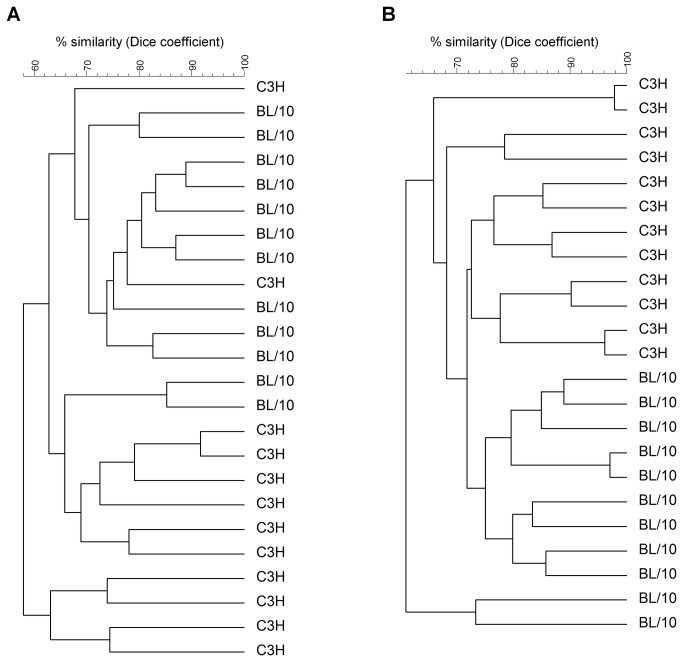
Cluster formation of C3H and C57BL/10 mice according to their luminal (A) and mucosa-associated (B) microbiota.Microbiota similarity in previously germ-free mice was calculated 13 weeks after association with the same bacterial inoculum using the Dice similarity coefficient and bottom-up cluster analysis (UPGMA) based on band patterns in DGGE gels.